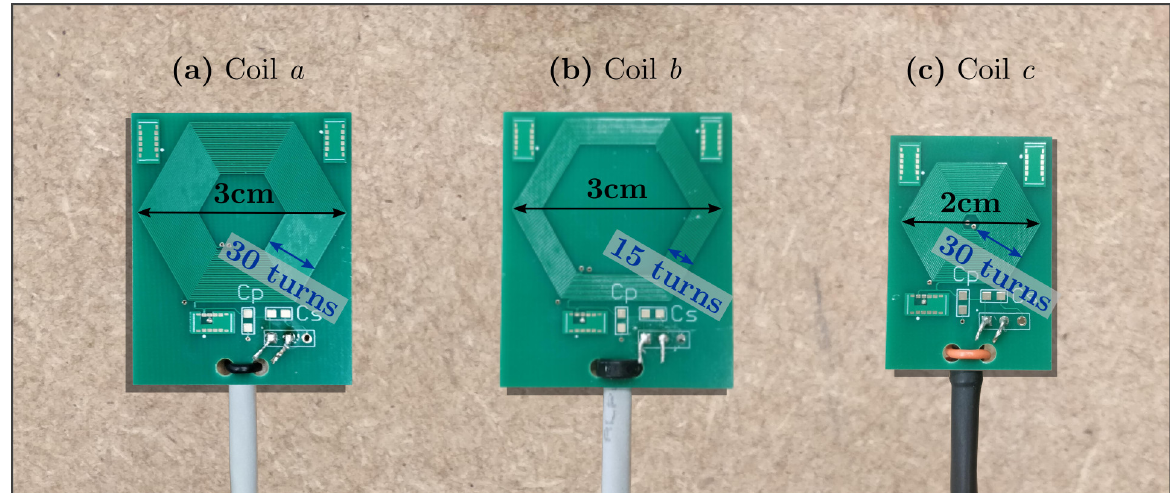
Figure 8. Three hexagonal sensors were manufactured on a 4-layer PCB. ( a ) The reference coil a has a diagonal, D out , of 3cm and 30 turns per layer. ( b ) Another version with 15 turns, and ( c ) a smaller coil with D out = 2cm, were manufactured to validate the formulas used in the coil design procedure.